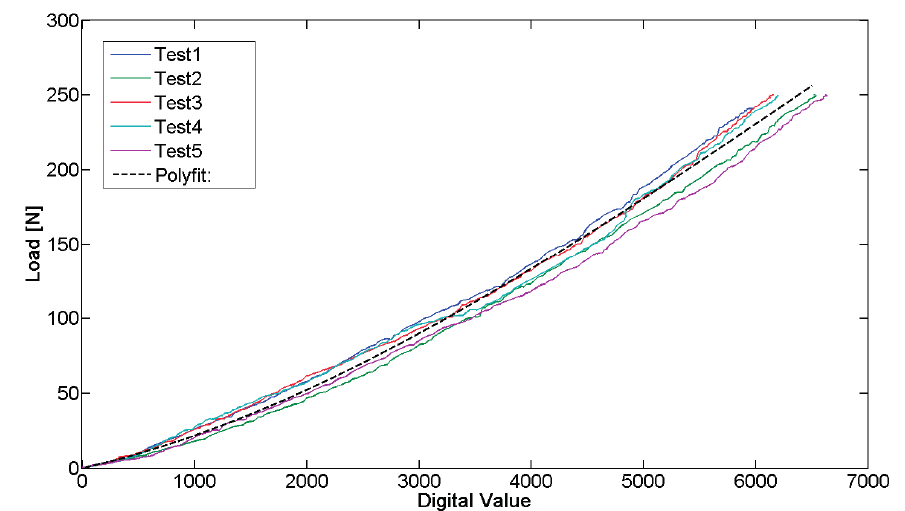
Figure 8. A sample of the calibration curves obtained from five tests performed on one of the five different FlexiForce sensors. The dotted line represents the polynomial interpolation of degree 3 that fits the data in a least squares sense. This curve was then used to convert the digital value provided by the system in the corresponding force value during the system